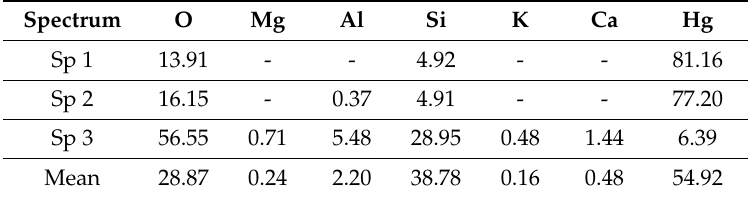
Table 4. Mass percentage values of the detected elements on the three marked points (Spectra, Sp) for NZHg.